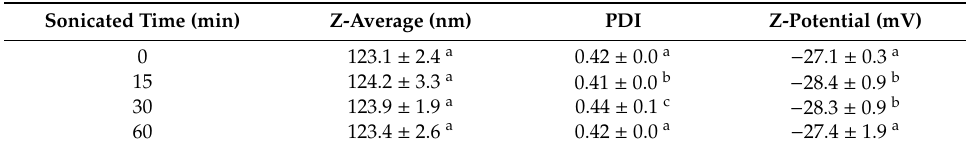
Table 1. Physical properties of nanoMIPs suspension with and without sonication. Different letters (a,b,c) indicate significant differences ( p < 0.05).